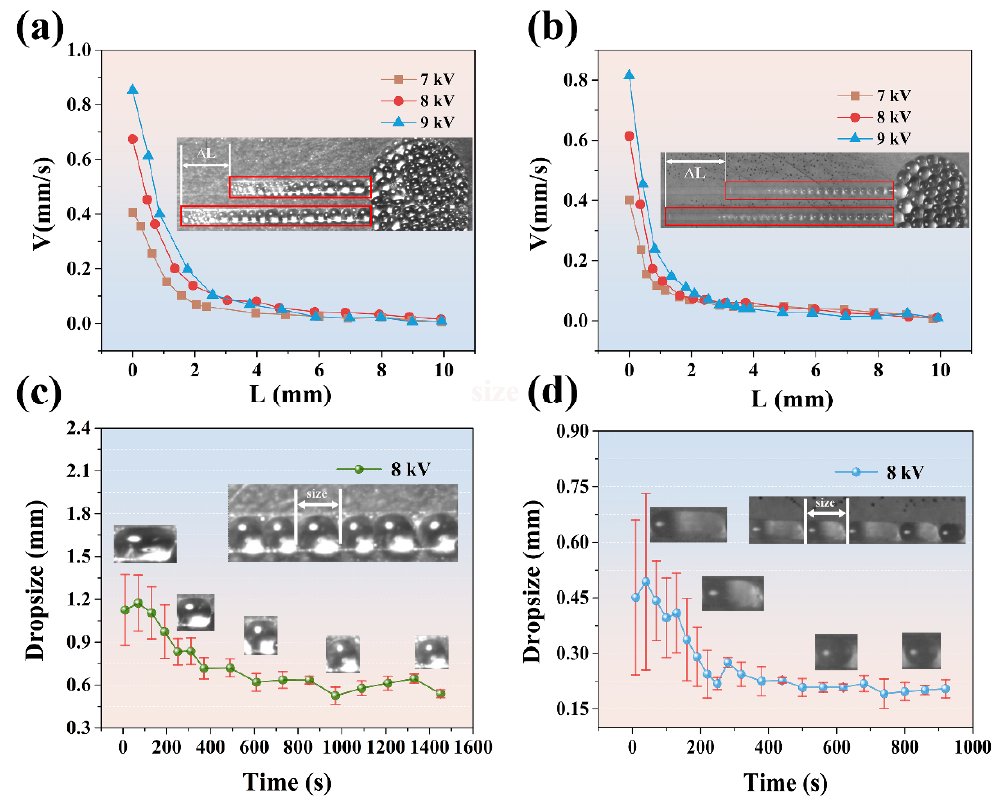
Figure 3. The speed and dielectric droplets size in microchannels. ( a ) The speed of dielectric droplets in channel width 0.5 mm. ( b ) The speed of dielectric droplets in channel width 0.2 mm. ( c ) The size of dielectric droplets in channel width 0.5 mm. ( d ) The size of dielectric droplets in channel width 0.2 mm.